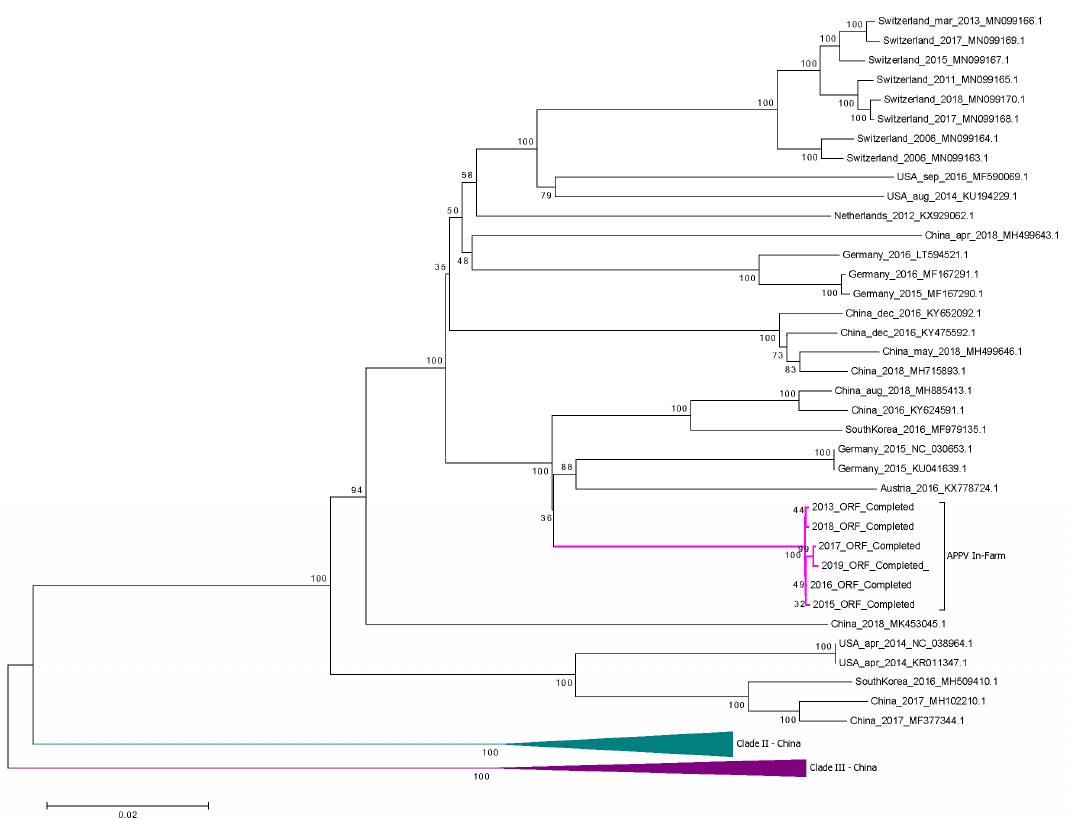
Figure 2. Phylogenetic analysis of the complete coding region alignment of atypical porcine pestivirus (APPV) sequences worldwide obtained from NCBI database and six APPV sequences retrieved in the present longitudinal study on the Dutch swine farm between 2013 and 2019. The neighbor-joining method with the Kimura two-parameter substitution model was used. Gaps and missing data were subjected to complete deletion. Bootstrap values are provided at the root of the clusters. The scale bar is a measure of the proportion of divergence. Run for 500 bootstrap replicates. Clade I shown as expanded tree. Clades II and III, containing only sequences from China, are collapsed and shown in green and purple in the lower part of the tree. APPV branches obtained in the current study are shown in pink. 3.5. Genome and Protein Variations of APPV within the Farm The samples with the highest numbers of APPV genome copies were selected from each of the years, and six full-length APPV genomic sequences from samples collected in the farm on 2013 and